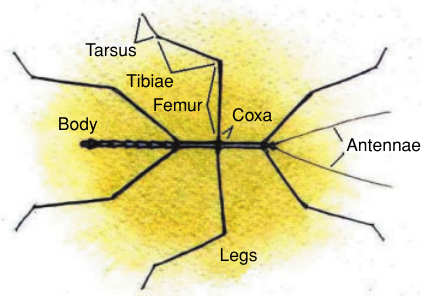
Figure 1 A sketch map of the stick insect.